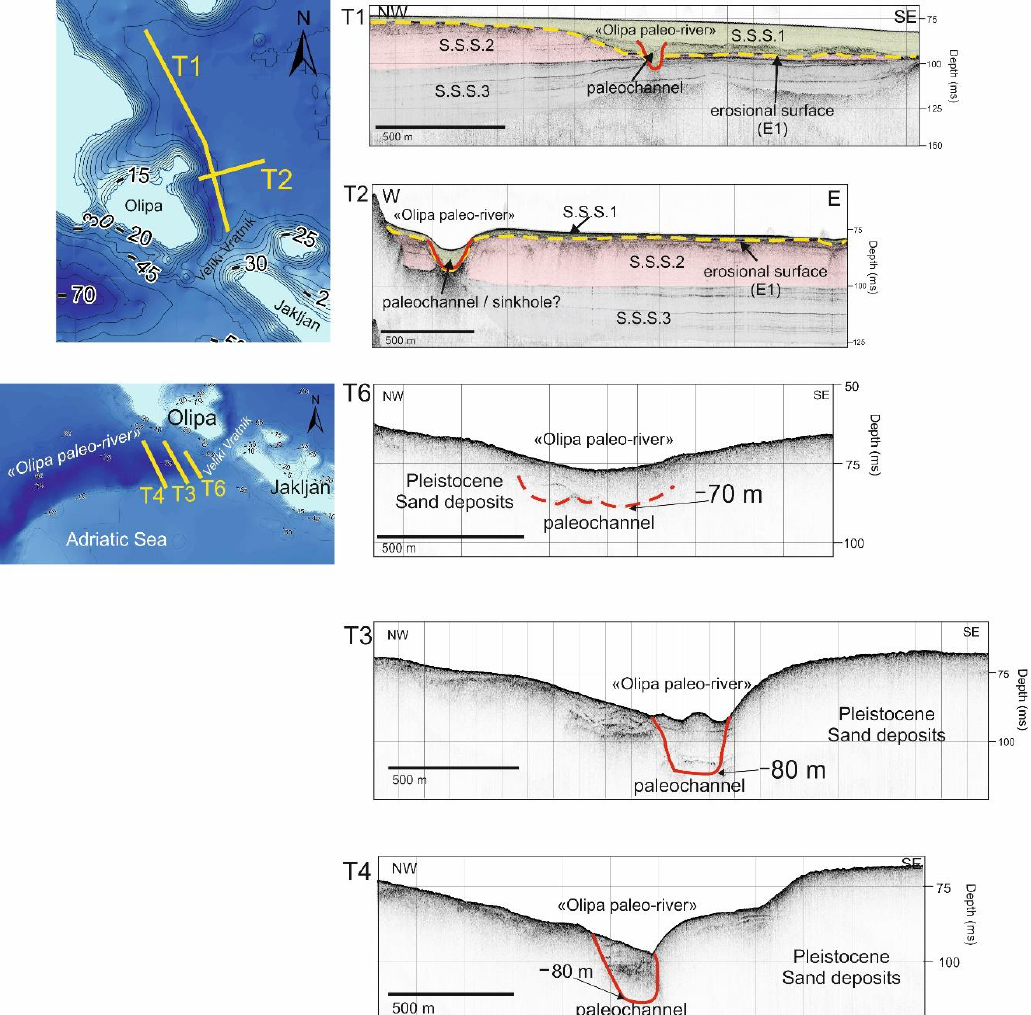
Figure 12. Pleistocene paleo-river channel of “Olipa River” observed on profiles T1 and T2 inside of Koločep bay, and Pleistocene paleo-river channel of “Olipa River” observed on profiles T6, T3 and T4 outside of Koločep bay towards Mljet Island.